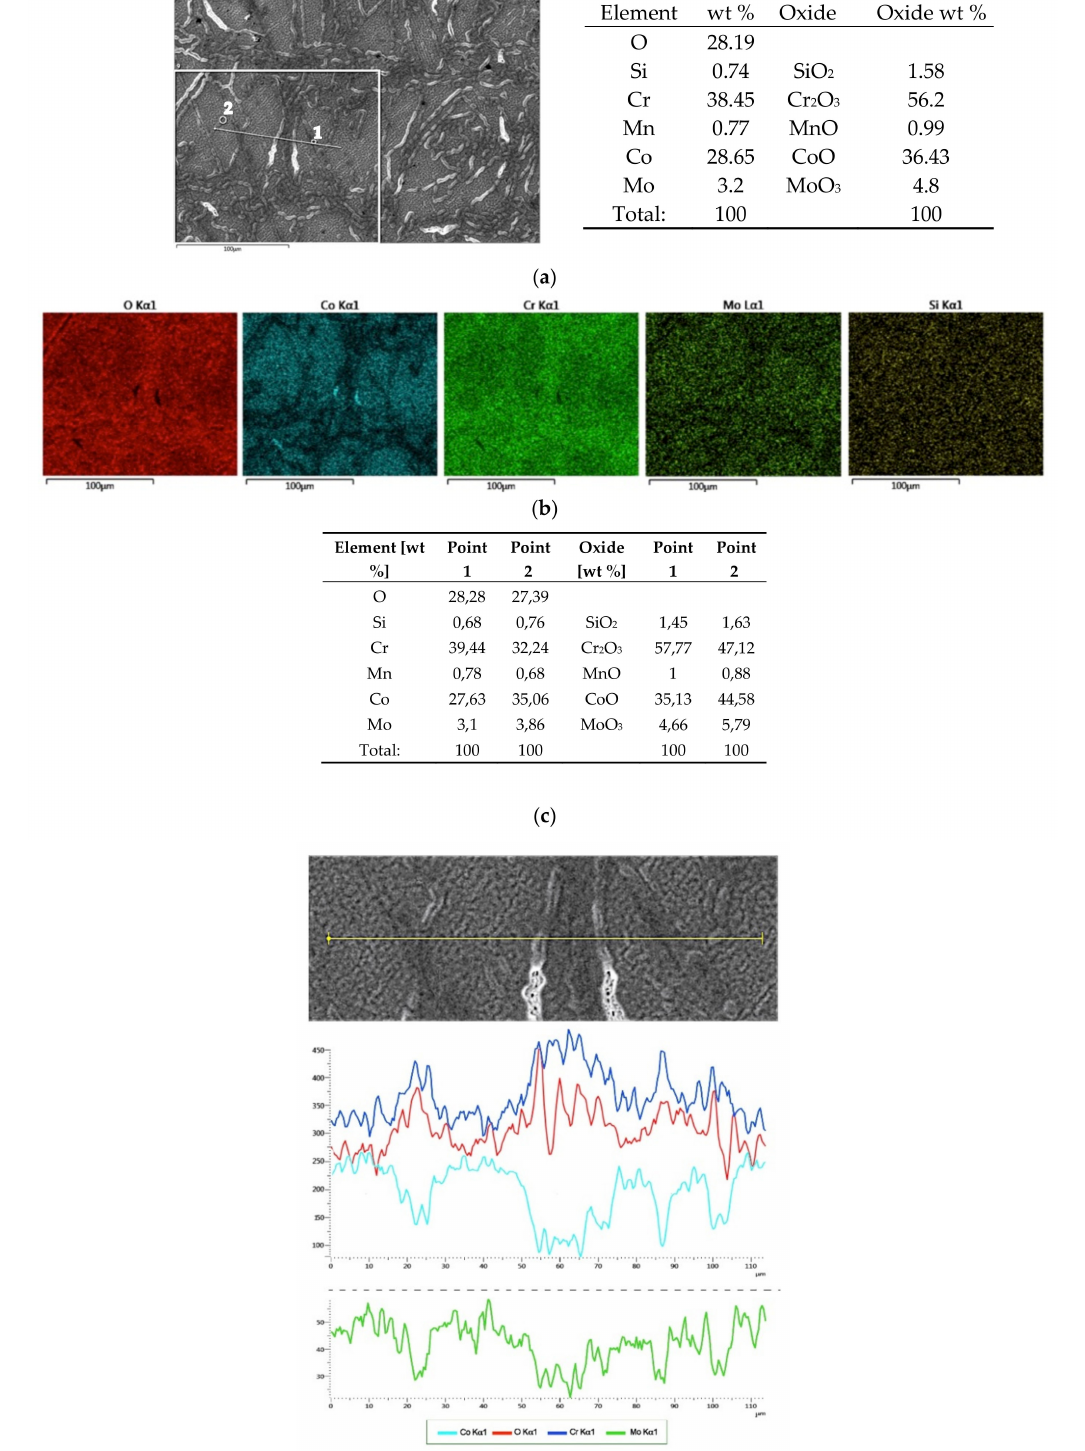
Figure 6. SEM EDS results for the SLM1 sample: ( a ) SEM-SE micrograph showing the morphology with average EDS results from the marked area; ( b ) maps presenting the surface distribution of O, Co, Cr, Mo, and Si; ( c ) EDS results for marked points; ( d ) SEM-SE micrograph with corresponding EDS line scan